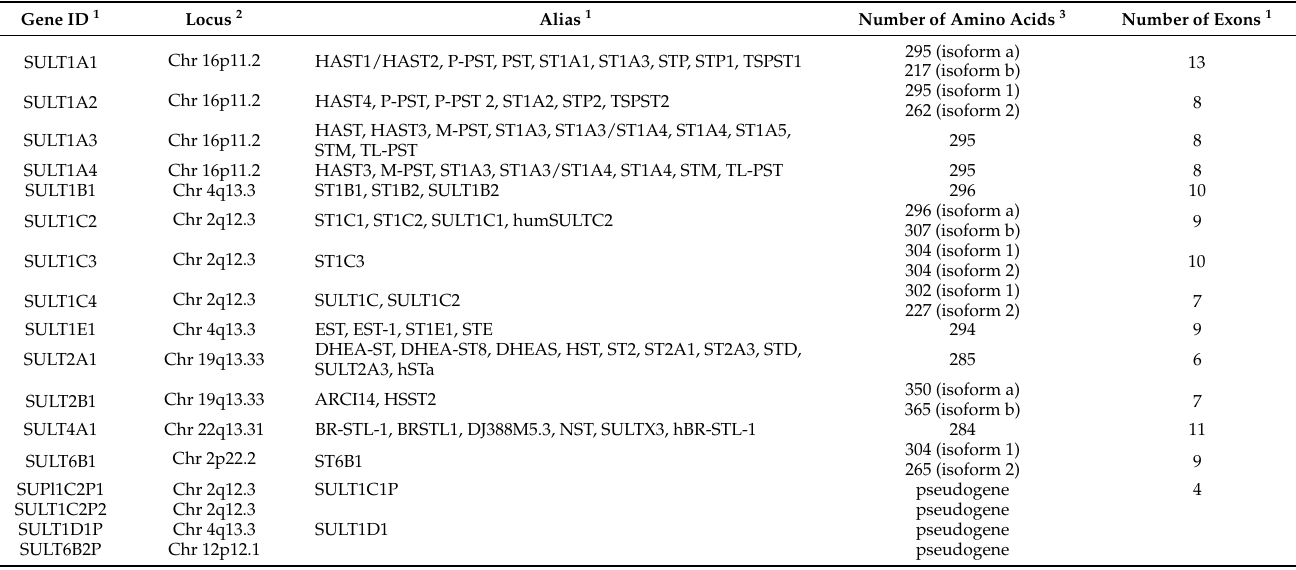
Table 1. Human sulfotransferase (SULT) isoforms.